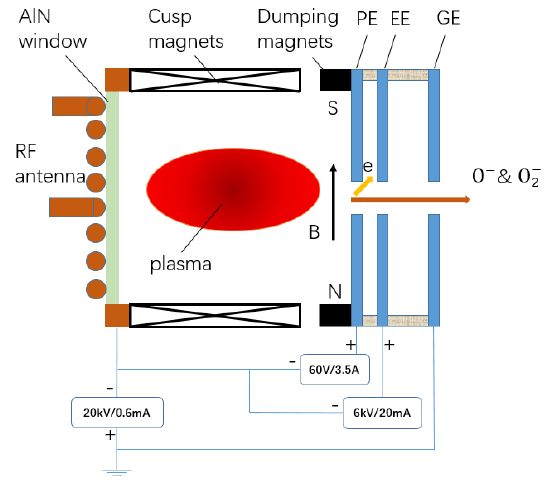
Figure 3. Schematic diagram of RF negative oxygen ion source.